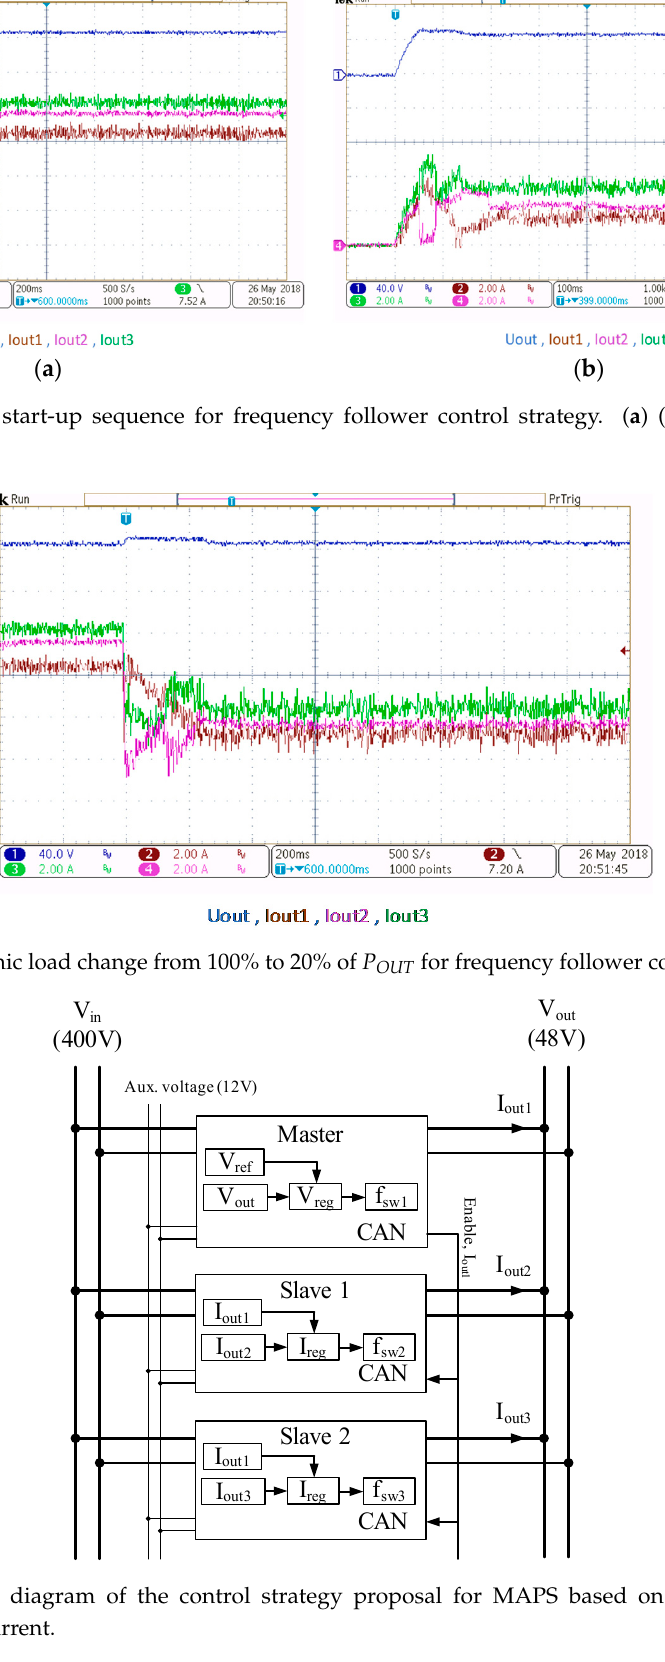
Figure 11. Block diagram of the control strategy proposal for MAPS based on the MASTER-voltage, SLAVE-current.